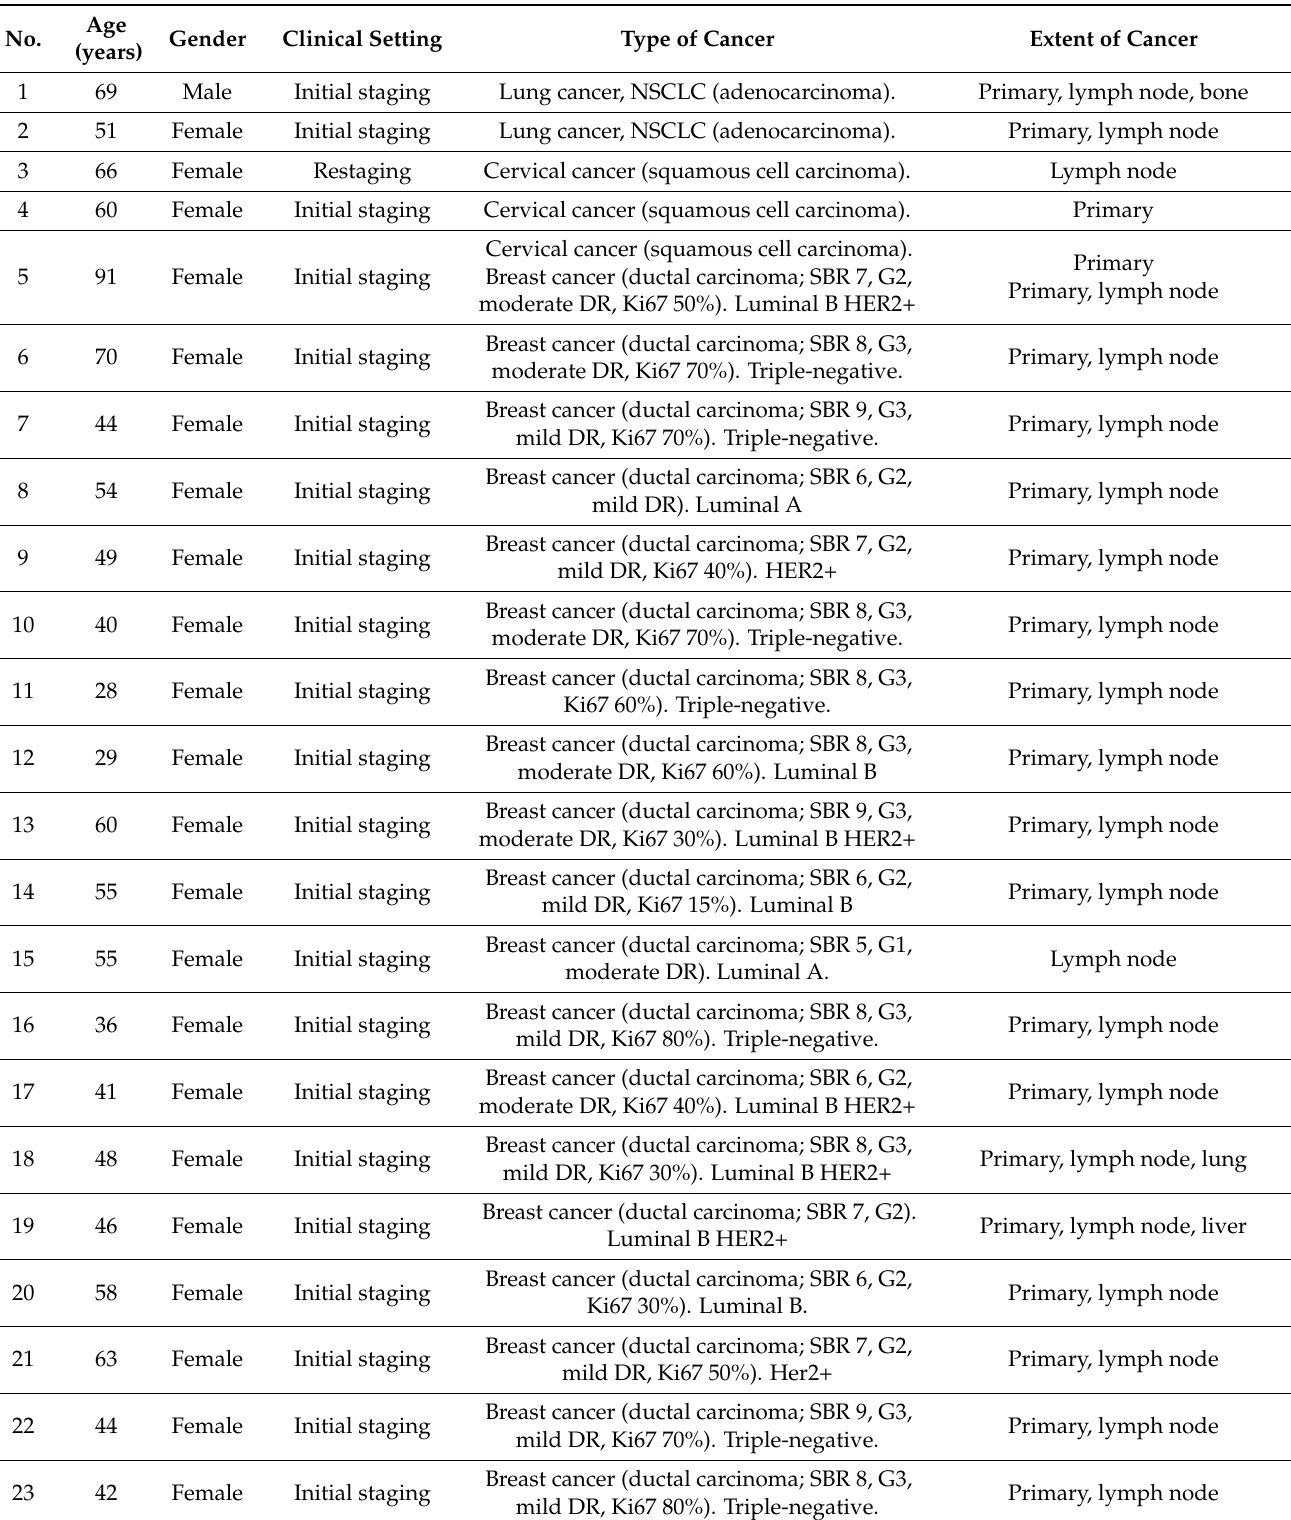
Table A1. Detailed description of the disease reported in cancer patients included in this research for tumor evaluation with the [ 99m Tc]Tc-iFAP